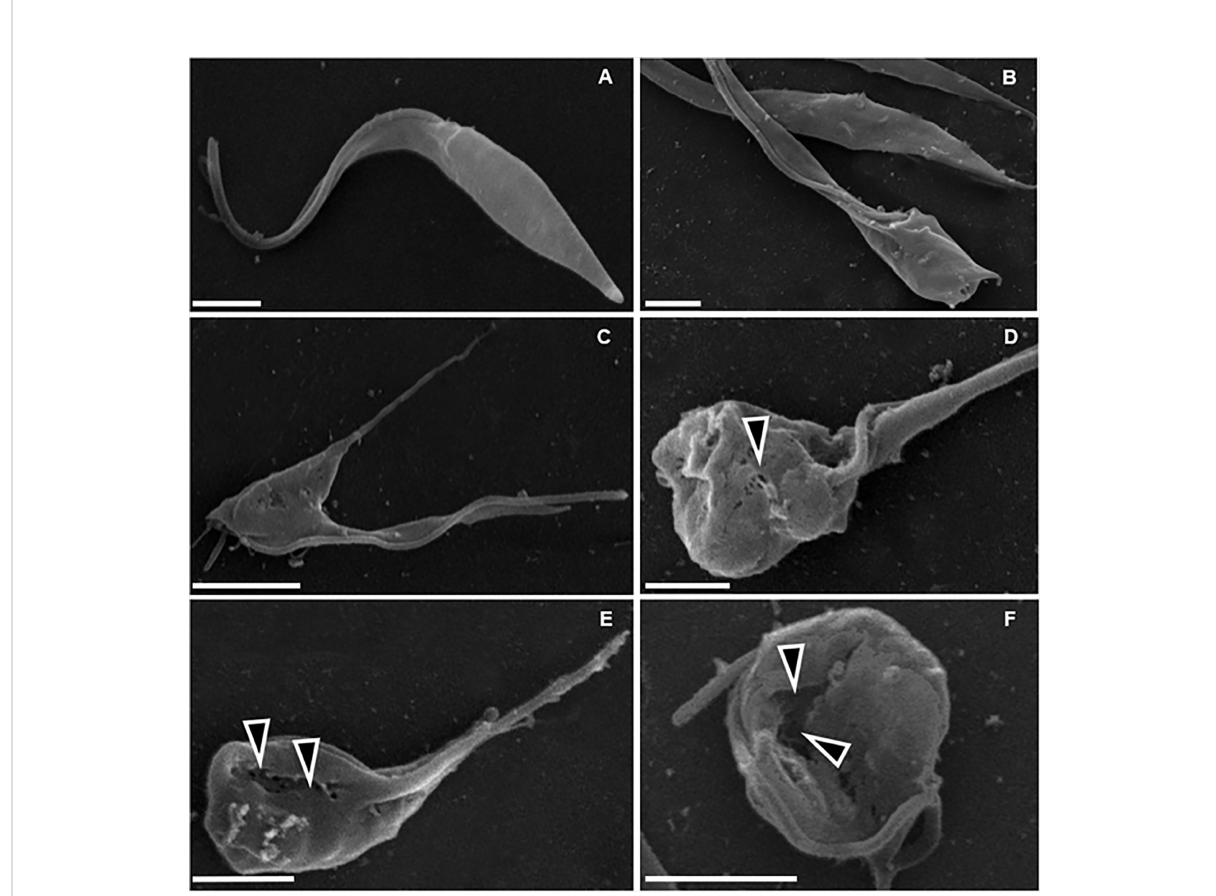
FIGURE 4 Scanning electron microscopy of T. cruzi epimastigote forms (Y strain). (A) Untreated control, showing normal parasite morphology. B – F ) Parasites treated with 200 µM DETC for 24 h, showing cellular disorganization (B, C) and plasma membrane discontinuities ( D – F , arrowheads), associated with cell body rounding and volume reduction. Bars correspond to 1